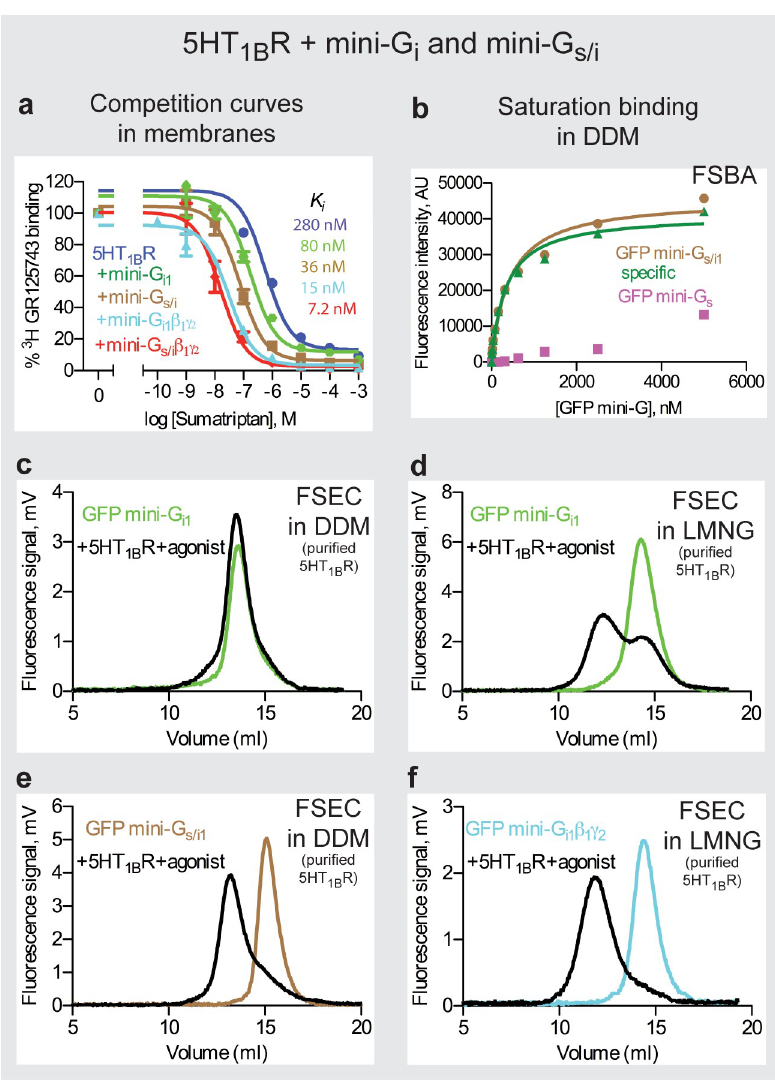
Fig 6. The 5HT 1B R − mini-G i1 complexes. ( a ) Mini-G i1 couplingincreasesagonist affinity to 5HT 1B R. Competition bindingcurves were performed in duplicate(n = 2) by measuring the displacement of the antagonist 3 H-GR125743 with increasing concentration of the agonistsumatriptan( K i values representing mean ± SEM in parentheses): blue circles, 5HT 1B R ( K i 280 ± 10 nM); green hexagons,5HT 1B R and mini-G i1 ( K i 80 ± 13 nM); brown squares, 5HT 1B R and mini-G s/i1 ( K i 36 ± 2 nM); pale blue triangles, 5HT 1B R and mini- G i1 β 1 γ 2 ( K i 15 ± 1 nM); red diamonds, 5HT 1B R and mini-G s/i1 β 1 γ 2 ( K i 7.2 ± 0.8 nM). Error bars represent the SEM. ( b ) Measurement of mini-G s/i1 chimeraaffinity to the DDM-solubilized, donitriptan-bound 5HT 1B R using FSBA: brown circles, 5HT 1B R and GFP-mini-G s/i1 (total binding);purple squares, 5HT 1B R and GFP-mini-G s (non-specific binding);green triangles, specific binding.The apparent K D of 390 ± 47 nM represents the mean ± SEM of two independent experiments. Curves shown are from a representative experiment. ( c ) FSEC traces of GFP-mini-G i1 with 5HT 1B R in DDM: black, GFP-mini-G i1 and donitriptan-bound 5HT 1B R purifiedin DDM (13.5 ml); green GFP-mini-G i1 (13.5 ml). ( d ) FSEC traces of GFP-mini-G i1 with 5HT 1B R in LMNG: black, GFP-mini-G i1 and donitriptan-bound 5HT 1B R purifiedin LMNG (12.2 ml and 14.3 ml); green, GFP-mini-G i1 (14.3 ml). ( e ) FSEC traces of GFP-mini-G s/i1 with 5HT 1B R: black, GFP-mini-G s/i1 and donitriptan-bound 5HT 1B R purifiedin DDM (13.2 ml); brown, GFP-mini-G s/i1 (15.1 ml). ( f ) FSEC traces of GFP-mini-G i1 β 1 γ 2 with 5HT 1B R: black, GFP-mini-G i1 β 1 γ 2 and donitriptan-bound 5HT 1B R purifiedin LMNG (11.8 ml); pale blue, GFP- mini-G i1 β 1 γ 2 (14.3 ml). In panels c-f , retention volumesare given in parentheses.